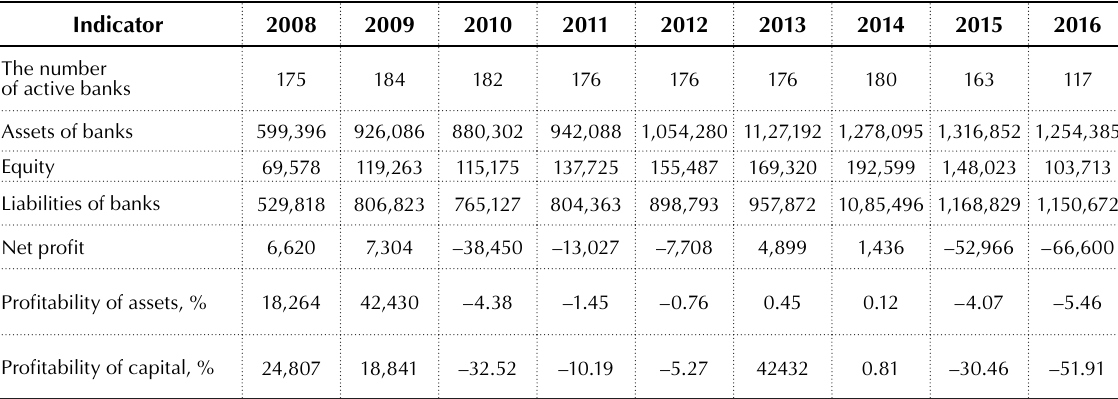
Table 1. The rate of decline in total assets and liabilities of Ukrainian banks (excluding exchange rate differences), UAH